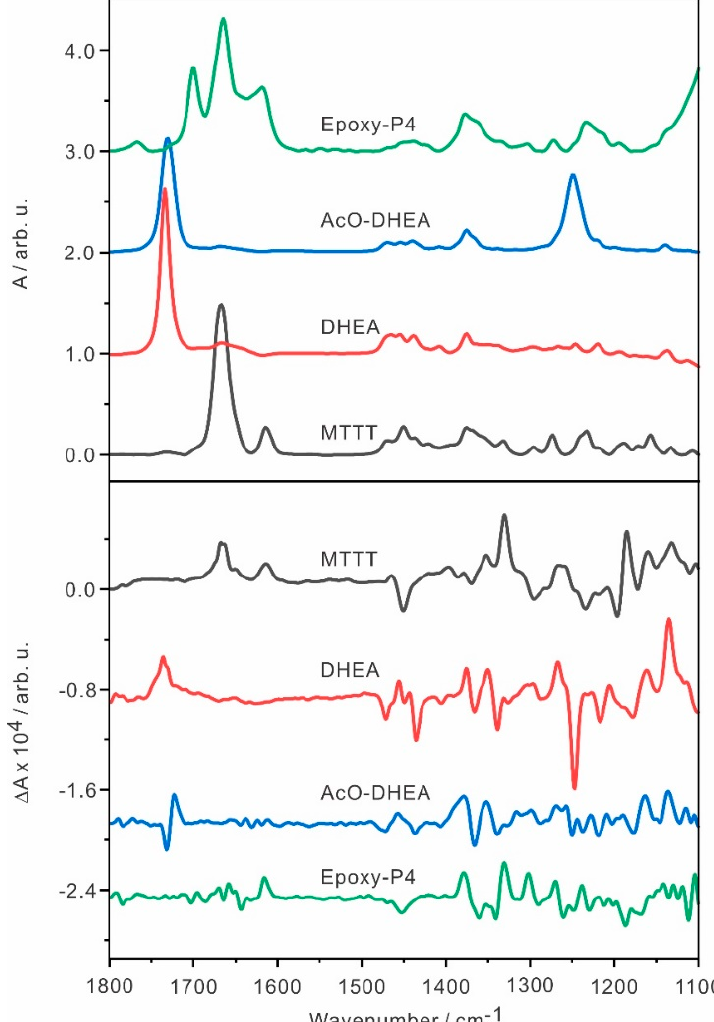
Figure 1. Experimental IR and VCD spectra of MTTT, DHEA, AcO − DHEA and Epoxy − P4 measured in DMSO − d 6 .